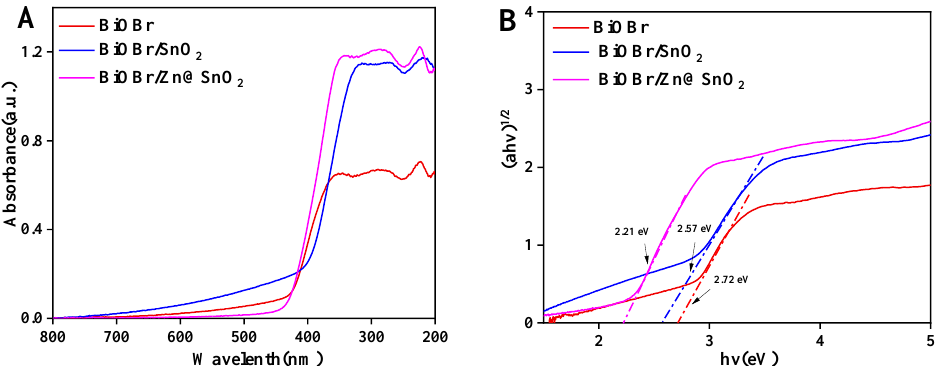
Figure 5. UV–vis diffuse reflectance spectra of BiOBr, BiOBr/SnO 2 and BiOBr/Zn@SnO 2 ( A ) and (ahv) 1/2 plotted against bandgap ( B ).